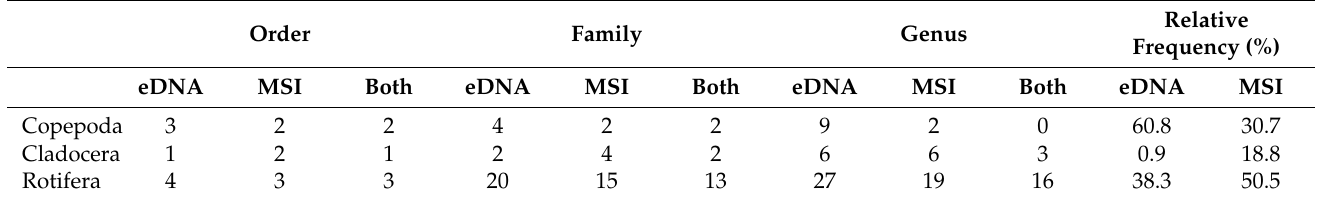
Table 2. Detected number of order, family, genus, and frequencies (%) of ASV and individuals according to each sampling method in the major taxa of